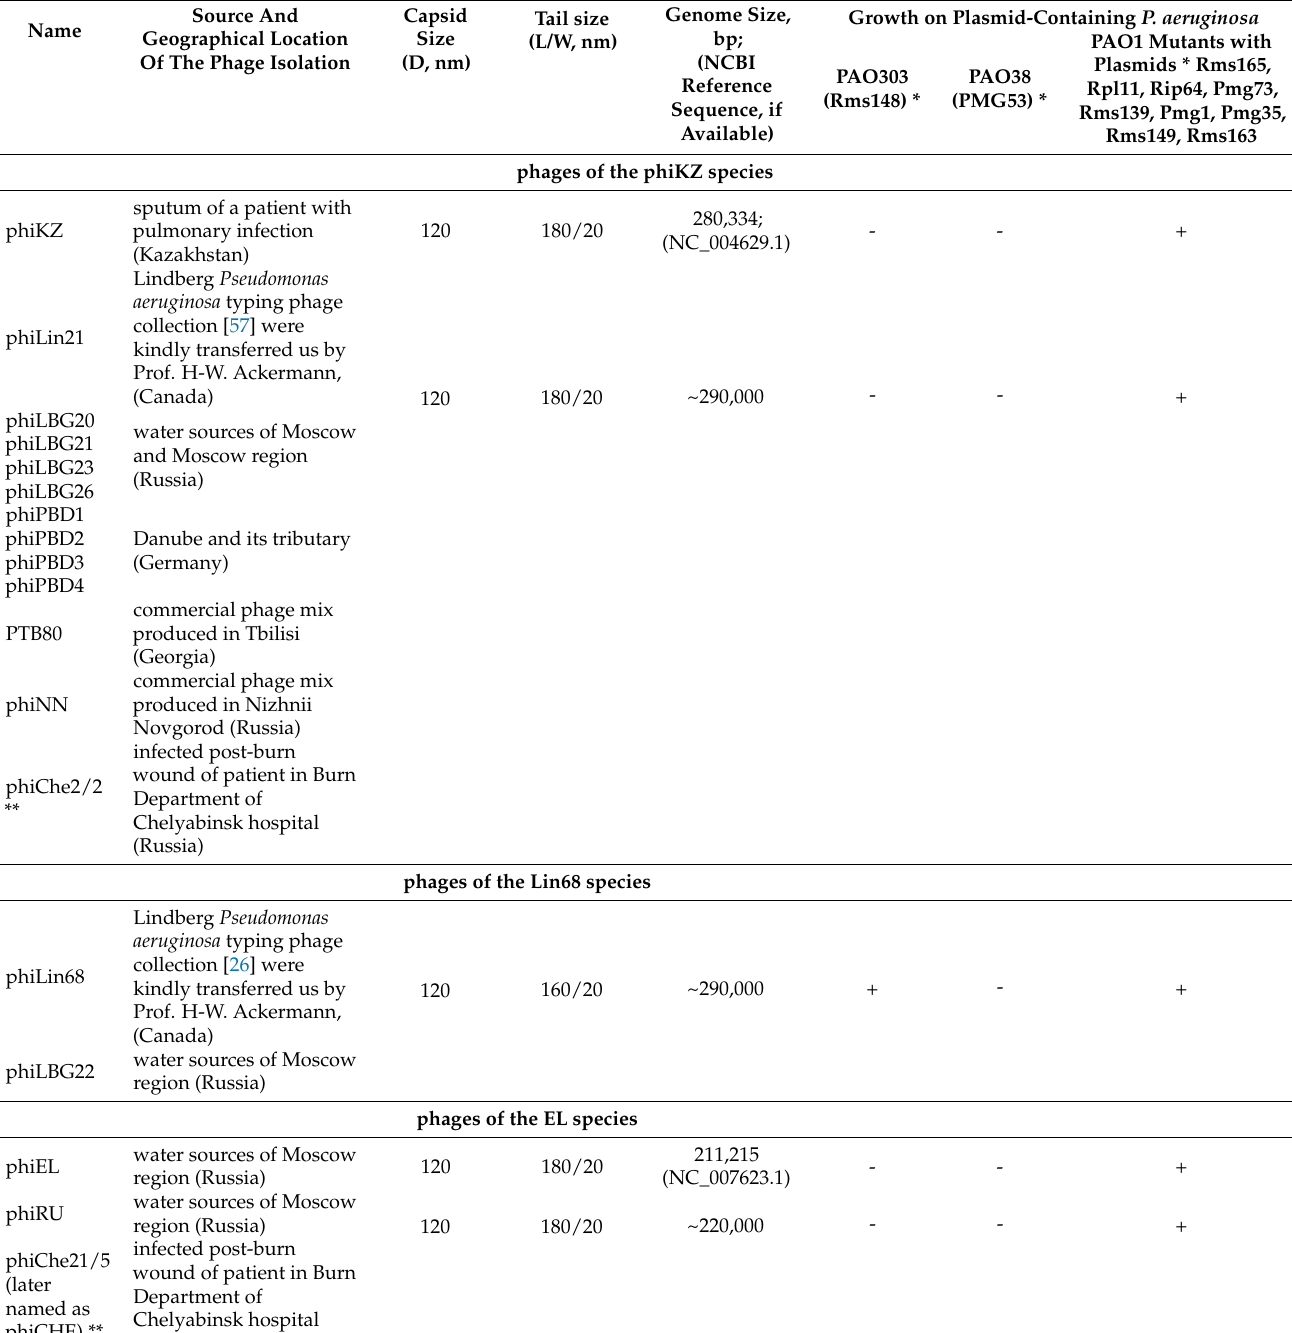
Table 2. Properties of Pseudomonas aeruginosa phiKZ-like phage